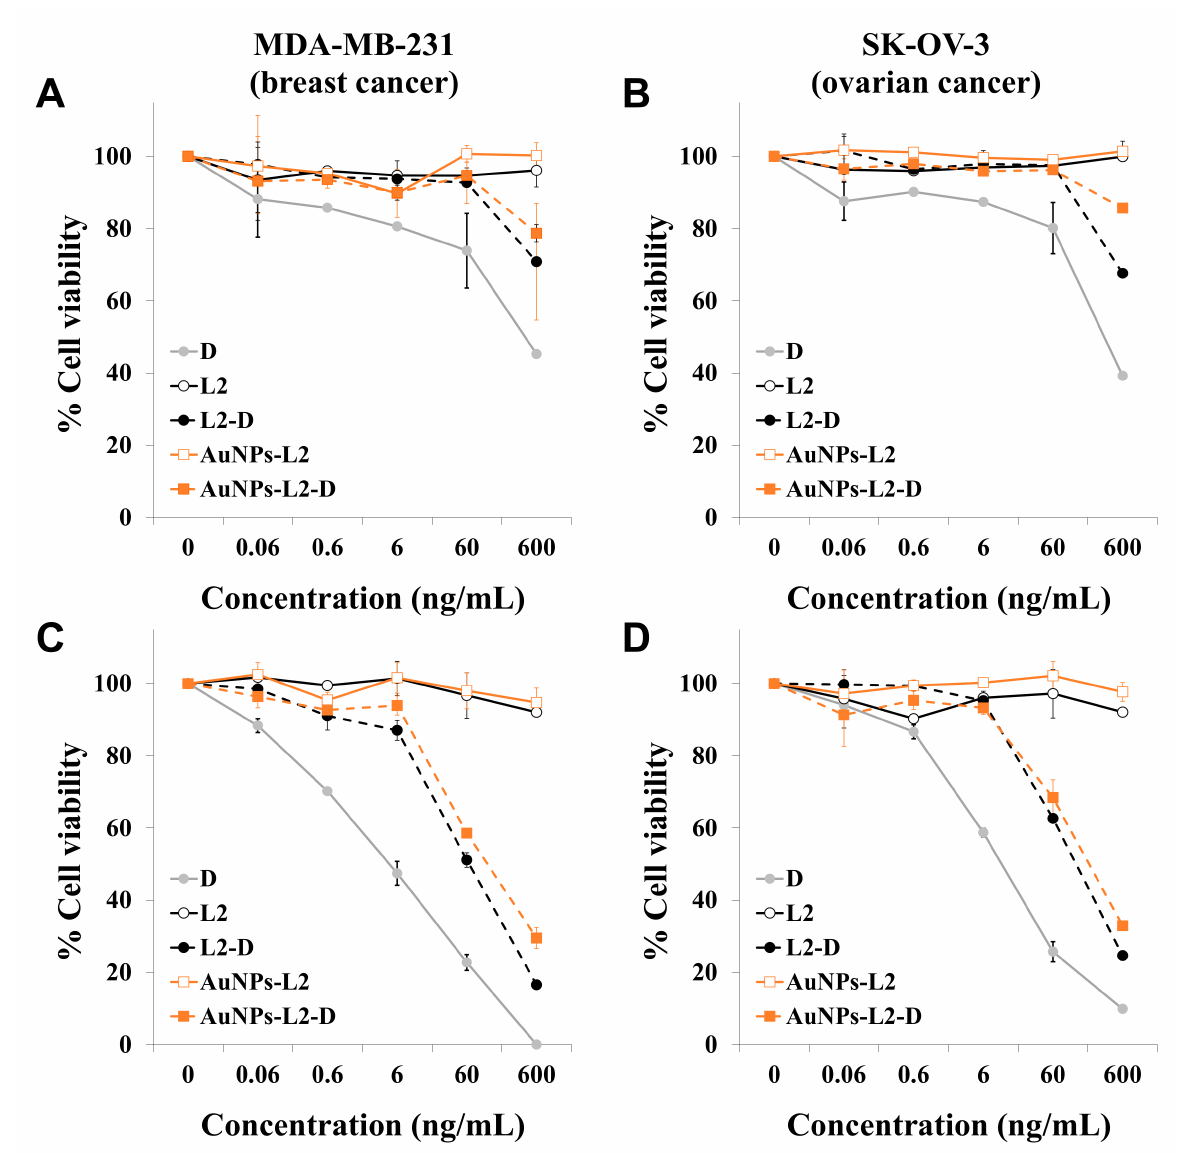
Figure 7. Evaluation of the cytotoxic activity of free doxorubicin ( D ), drug unloaded liposomes, non-functionalized and functionalized with gold nanoparticles (L2 and AuNPs-L2, respectively) and D-loaded liposomes (L2-D and AuNPs-L2-D, respectively). MDA-MB-231 breast cancer cells and SK-OV-3 ovarian cancer cells were treated for 2 h ( A , B ), followed by a recovery period of 70 h in drug-free medium, or cells were continuously exposed to compounds for 72 h ( C , D , respectively). Finally, cell viability was determined by the resazurin assay. The concentrations of the unloaded L represented in the graphs are those used to deliver the concentrations of D shown on the x-axis of the graphs. Data are reported as means ± standard error of mean (SEM) and were obtained from two independent experiments. L2 corresponds to the liposome series with 40 mol% of